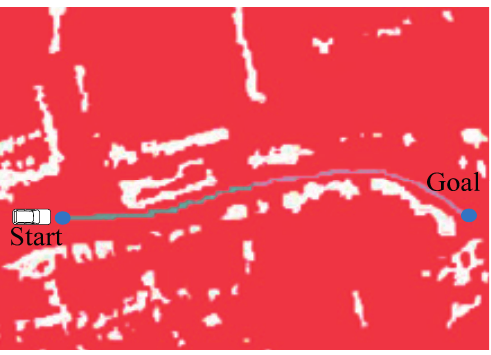
Figure 17. The path planning result of RRT+Bezier in scenario 5.